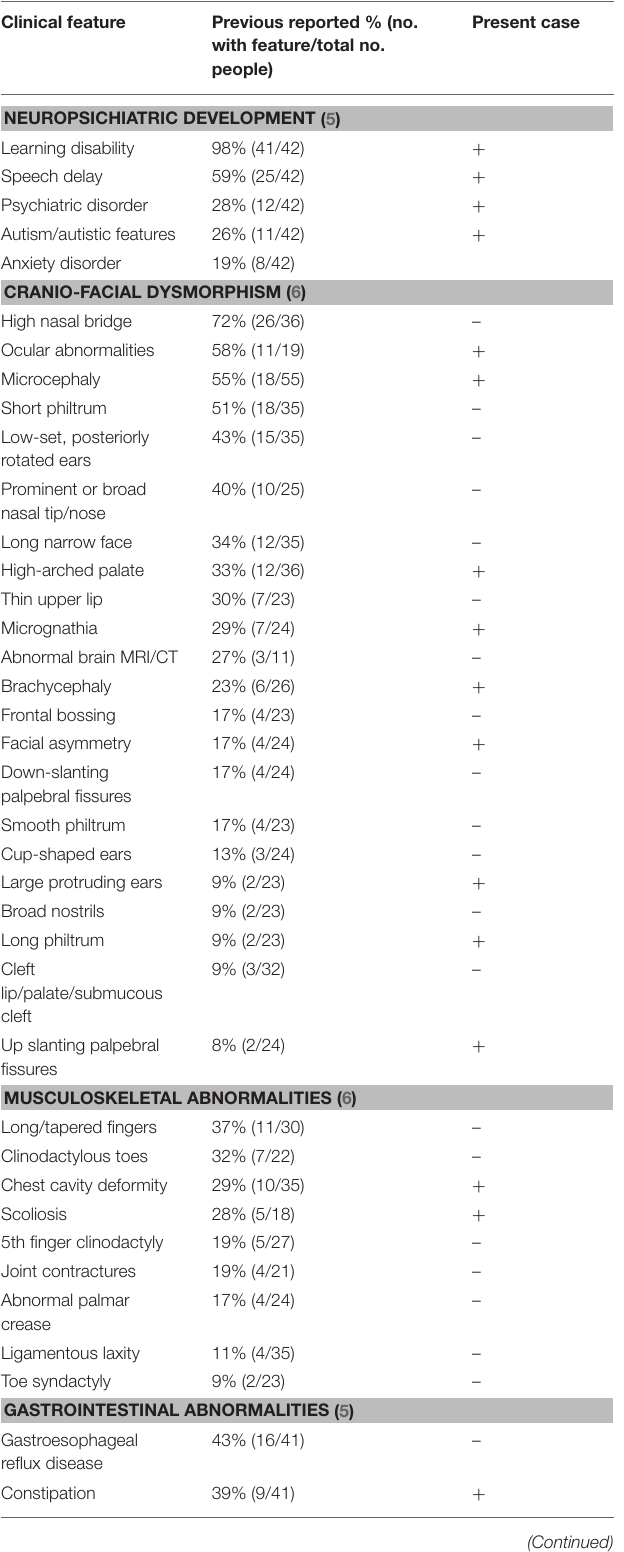
with feature/total